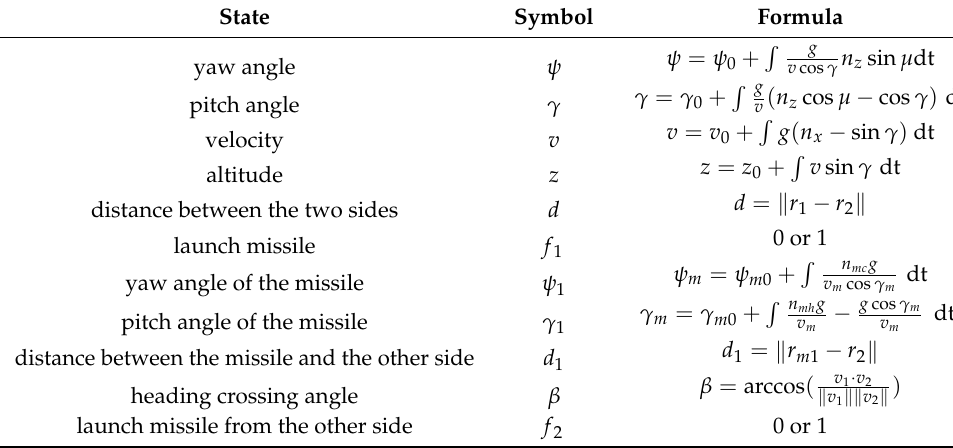
Table 1. Air combat